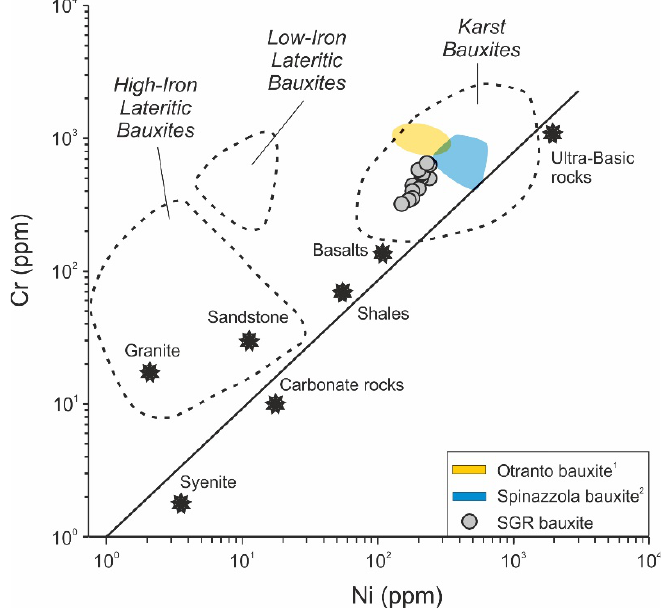
Figure 9. Ni versus Cr diagram showing the distribution of the SGR, Spinazzola, and Otranto karst bauxites. Modified after Schroll, et al. [52].